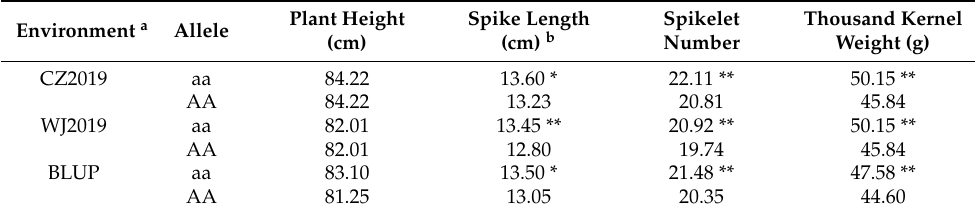
Table 5. Effects of QSlu.sicau-2B-2 on the yield-related traits in the H461 × HC42 recombinant inbred line